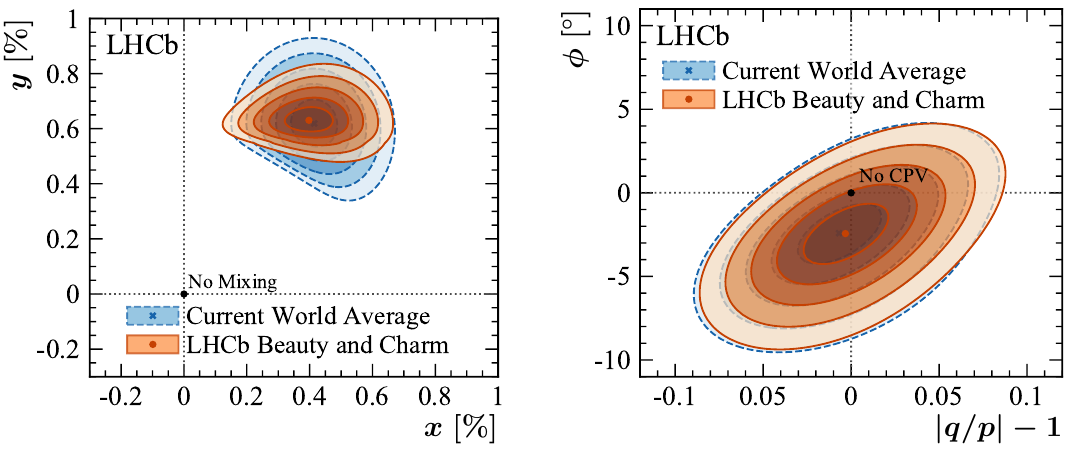
Figure 2 . One dimensional 1 − CL profiles for γ from the combination using inputs from B 0 blue), B 0 (orange), B + mesons (red) and all species together (dark blue).